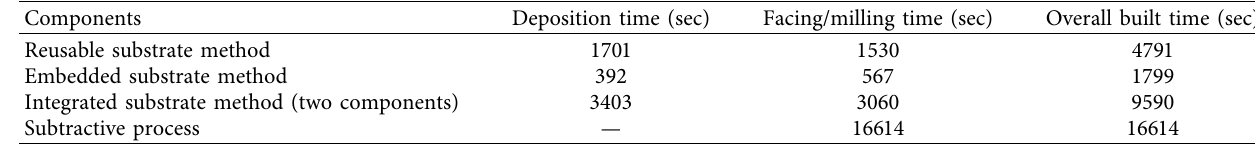
Table 4: Built time for the components with different build strategies.